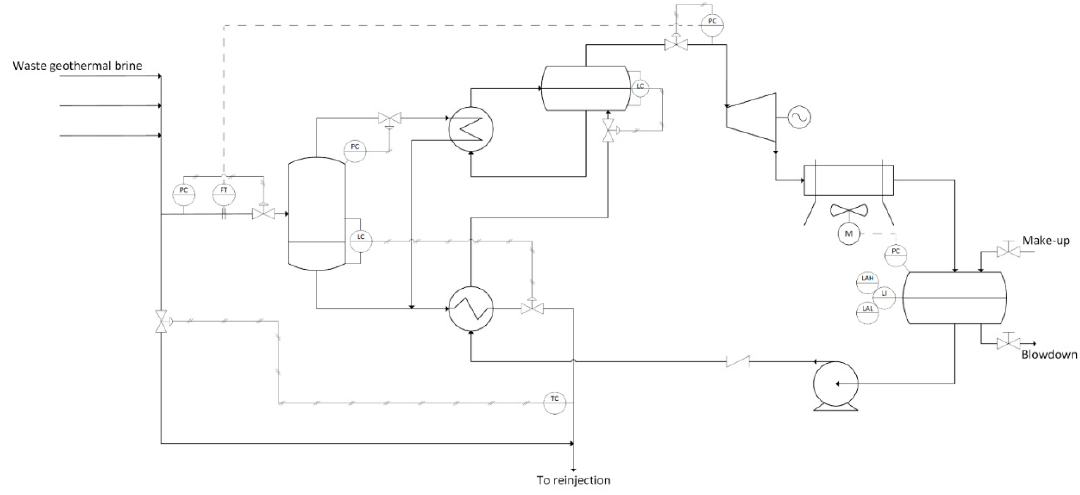
Water 2020 , 12 , 316 Figure 5. Process scheme of the proposed solution for energy recovery (case study 1a, Bagnore).